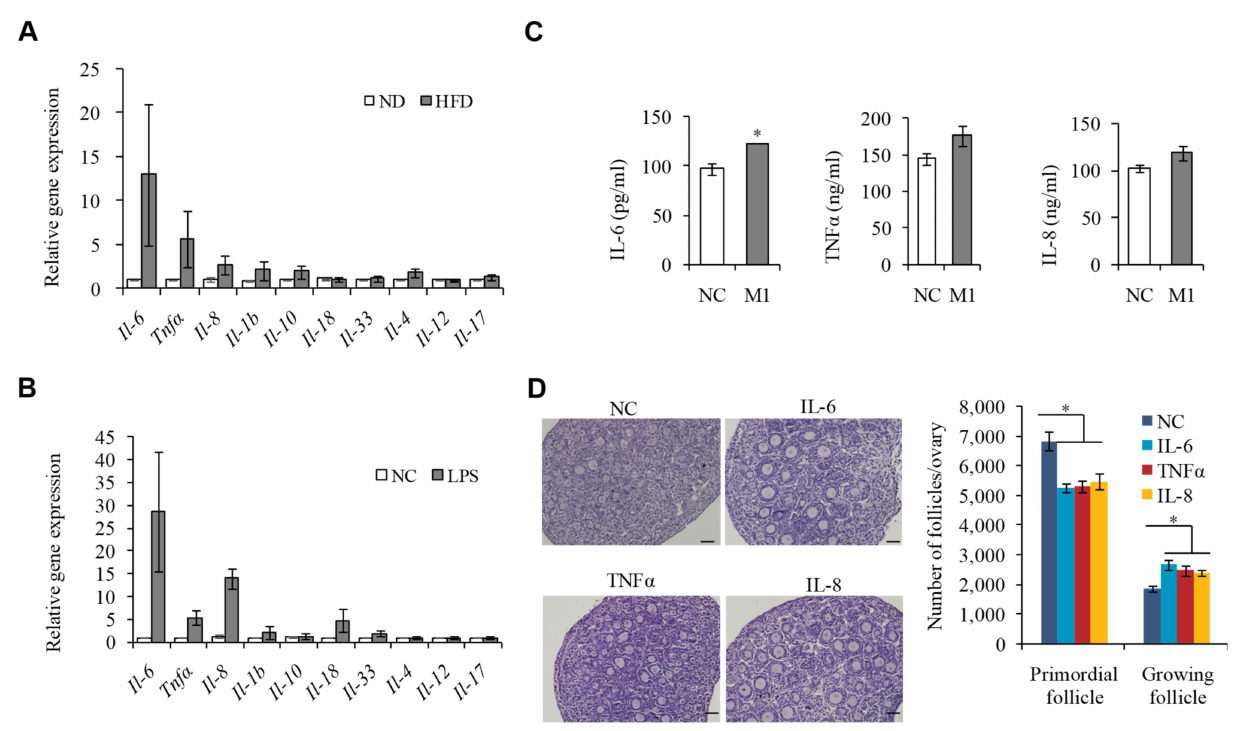
Figure 4. Macrophage (M1) exhibits proinflammatory actions by secreting cytokine IL-6, IL-8, and TNF α to promote the overactivation of primordial follicles. ( A , B ) qPCR analysis of the mRNA levels of pro-inflammatory cytokines in the ovaries of ND and HFD mice ( A ), and NC and LPS-treated mice ( B ). ( C ) ELISIA assay detecting IL-8, TNF α , and IL-6 protein levels in culture medium with or without M1 type macrophage extracted from enterocoelia of the HFD mice ( n = 3). ( D ) Representative H&E staining images and follicle number counts in the 3 dpp mouse ovaries supplemented with IL-8, IL-6, or TNF α compared to control mice ( n = 10). Scale bar = 50 µ m. * p <